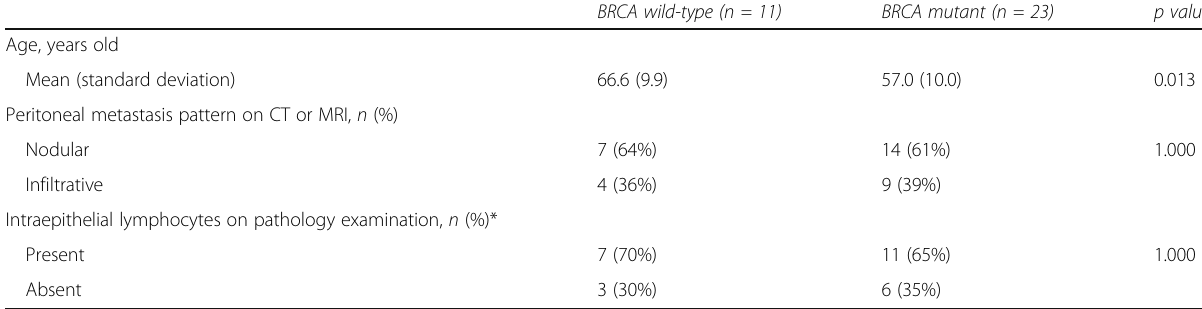
Table 1 Demographic, clinical, and pathologic data of BRCA -mutant HGSC and BRCA-wild type